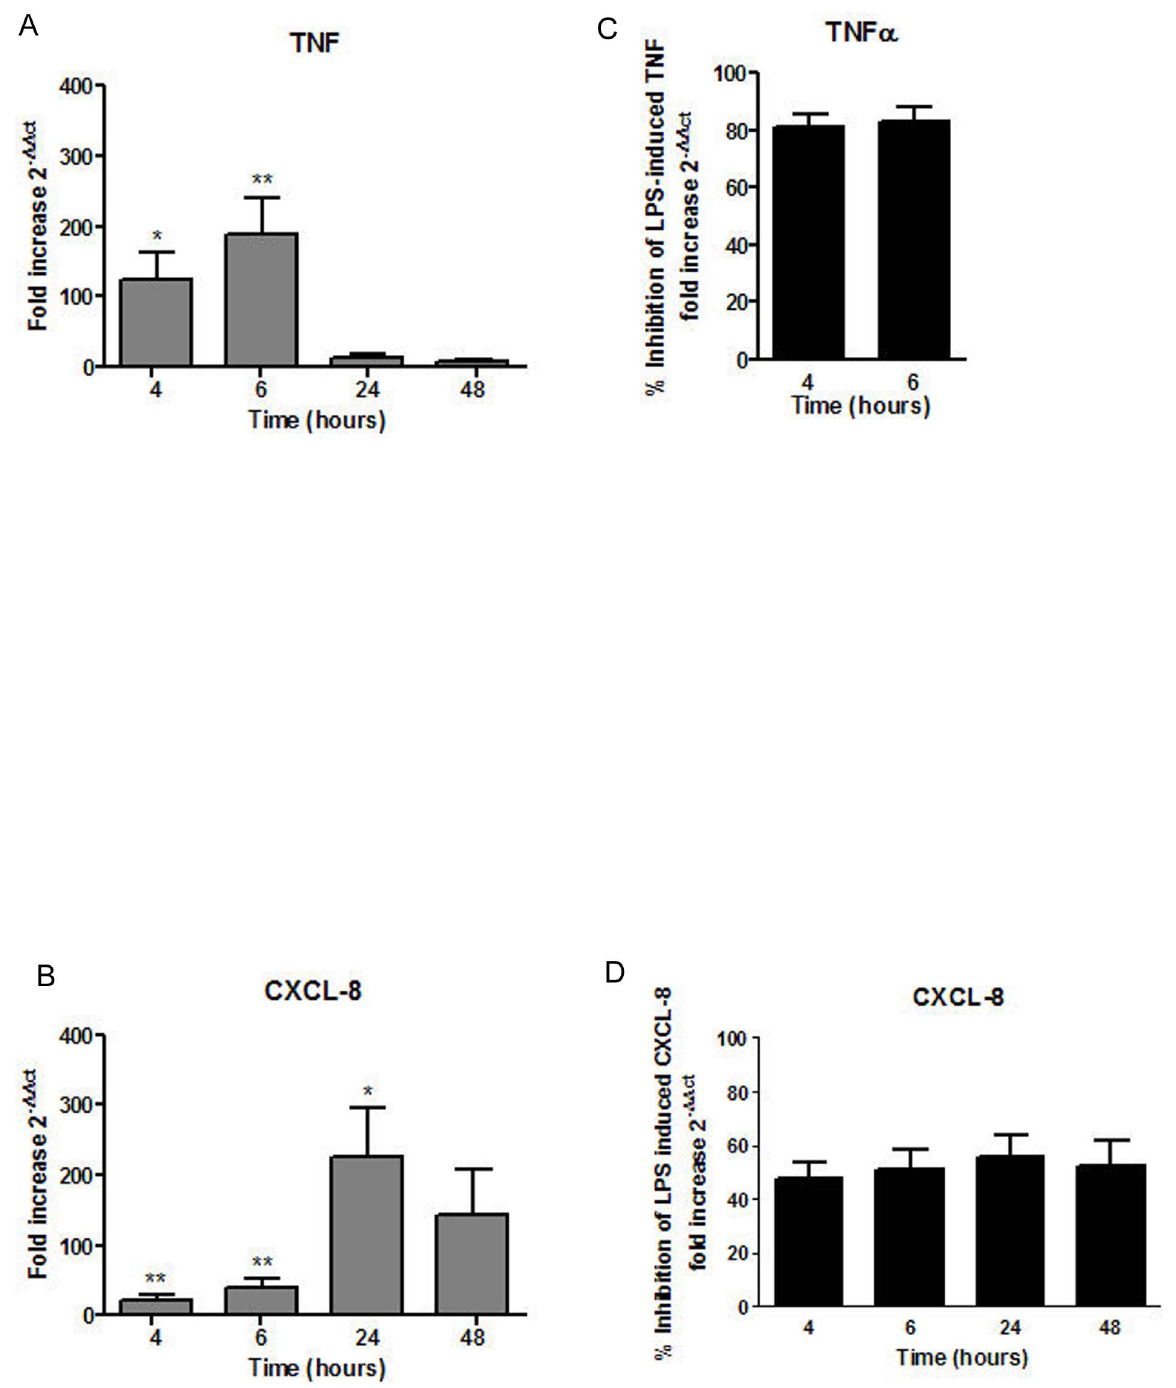
Figure 3. 17-BMP inhibition of LPS-stimulated cytokine transcription. Lung macrophages (COPD n=4 and S n=3) were treated with LPS (1 ug/ml) for 4, 6, 24 and 48 h and CXCL8 and TNF a mRNA levels were measured. Data are presented as fold change over time compared to time matched unstimulated controls for (A) TNF a and (B) CXCL8. The effect of 17-BMP on (C) TNF a transcription and (D) CXCL8 transcription was also analysed and presented as % Inhibition of LPS-induced TNF fold increase. *=significantly above time matched unstimulated control (p , 0.05) **=significantly above time matched unstimulated control (p , 0.01). doi:10.1371/journal.pone.0064257.g003 ser226 phosphorylation in alveolar macrophages between groups, alveolar macrophages expressed phosphorylation of GR at ser203, with only a minor increase in ser203 expression in alveolar ser211 and ser226 (Fig. 6D–F). GR was found to be phosphor- macrophages from COPD patients and S compared to NS ylated in a high proportion of macrophages in both COPD (p = 0.0002, Fig. 6G–H). patients and controls. There was no difference in ser211 and